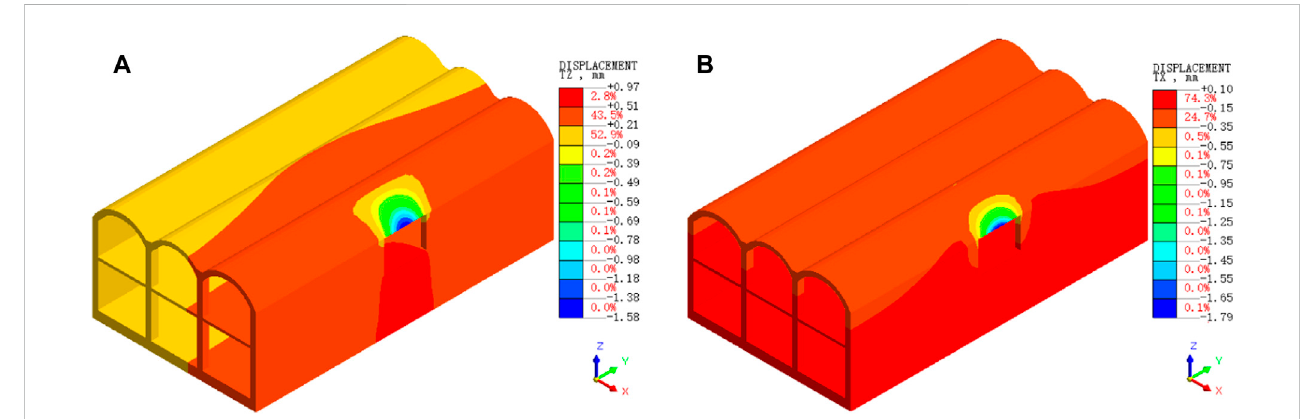
FIGURE 10 Vertical and horizontal deformations of existing station structure (mm): (A) Vertical deformation and (B) Horizontal